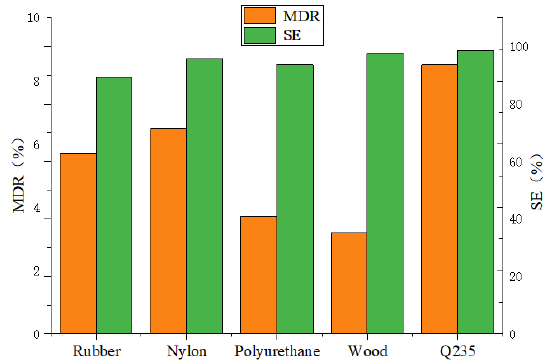
Figure 4. Relationship between MDR and SE for different materials.